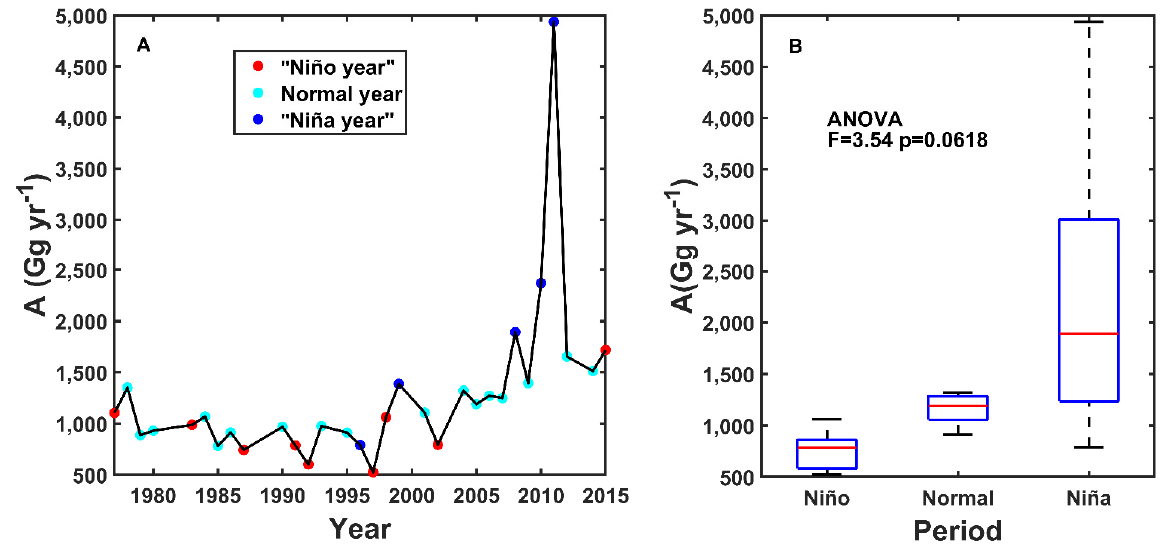
Figure 9. Evolution of the estimated soil loss over time in the Tonusco River watershed ( A ) and comparison of soil loss between El Niño, La Niña, and normal years ( B ).